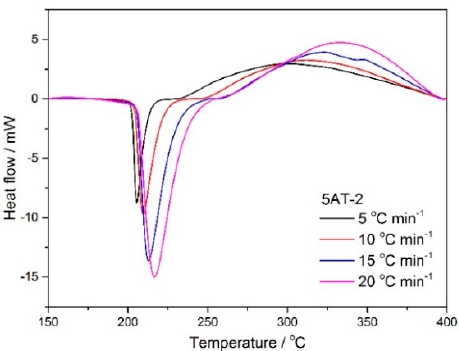
Figure 8. DSC profiles of 5AT–2 using four different heating rates. Figure 8. DSC pro fi les of 5AT–2 using four di ff erent heating rates. Figure 8. DSC pro fi les of 5AT–2 using four di ff erent heating rates.